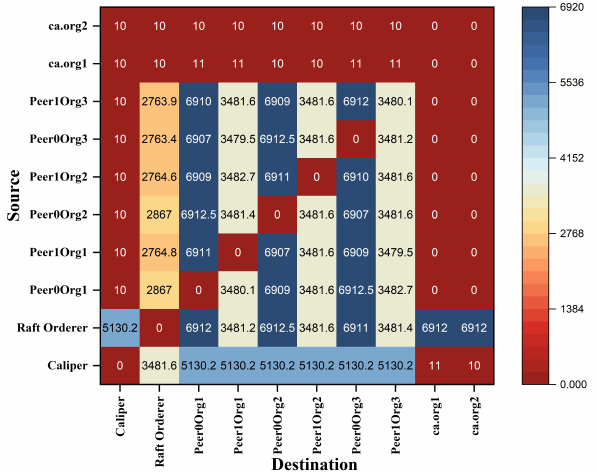
Figure 10. Heatmap of Transaction Traffic Gossip (SOLO).